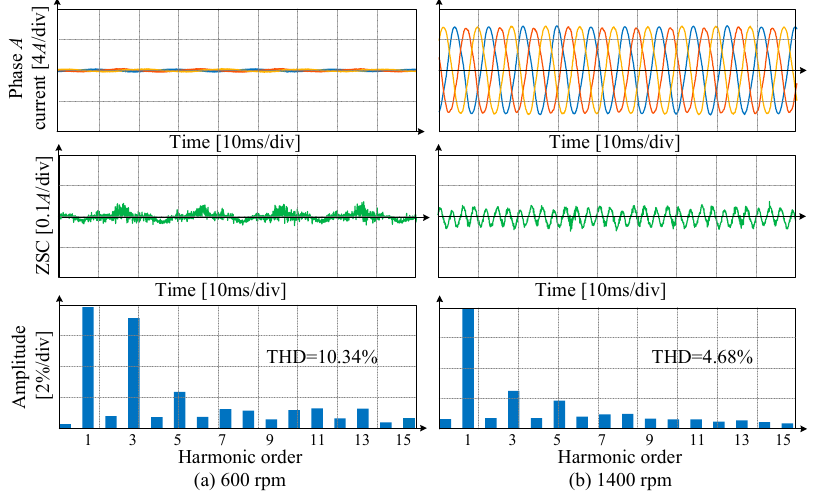
Figure 24. Steady-state performance of FW-DFVL under no load ( a ) 600 rpm situation ( b ) 1400 rpm situation.